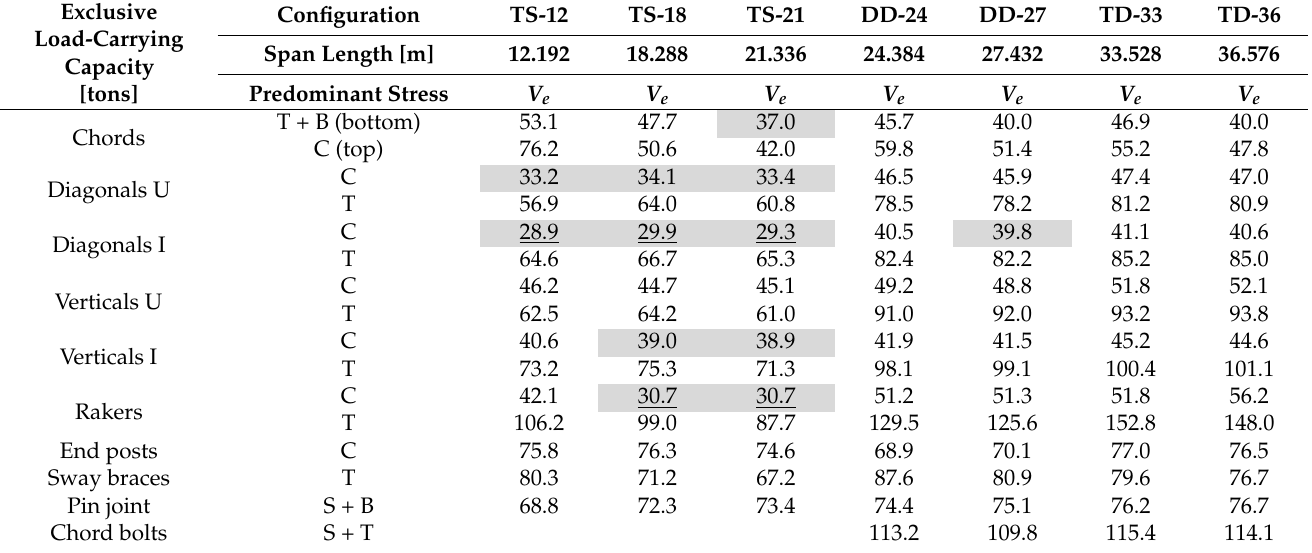
Table 4. Exclusive load-carrying capacities of main girders parts.